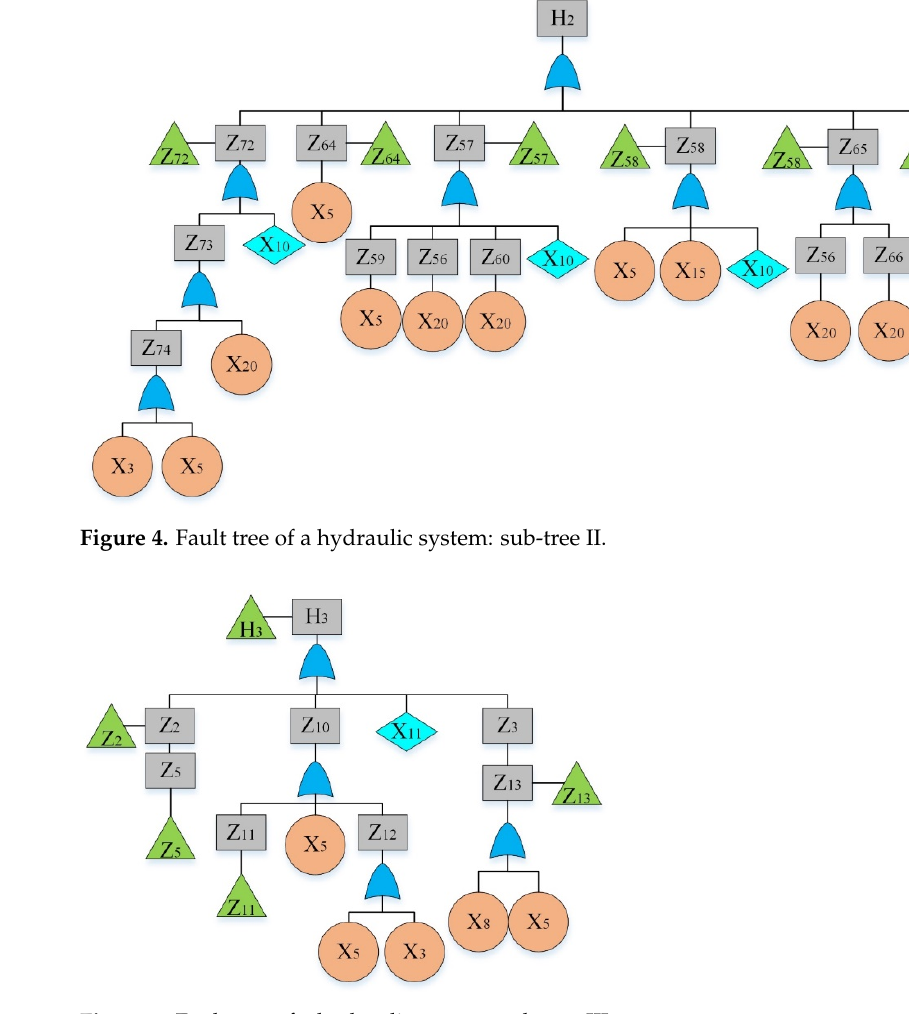
Figure 6. Fault tree of a hydraulic system: sub-tree IV. Figure 7. Fault tree of a hydraulic system: sub-tree V.